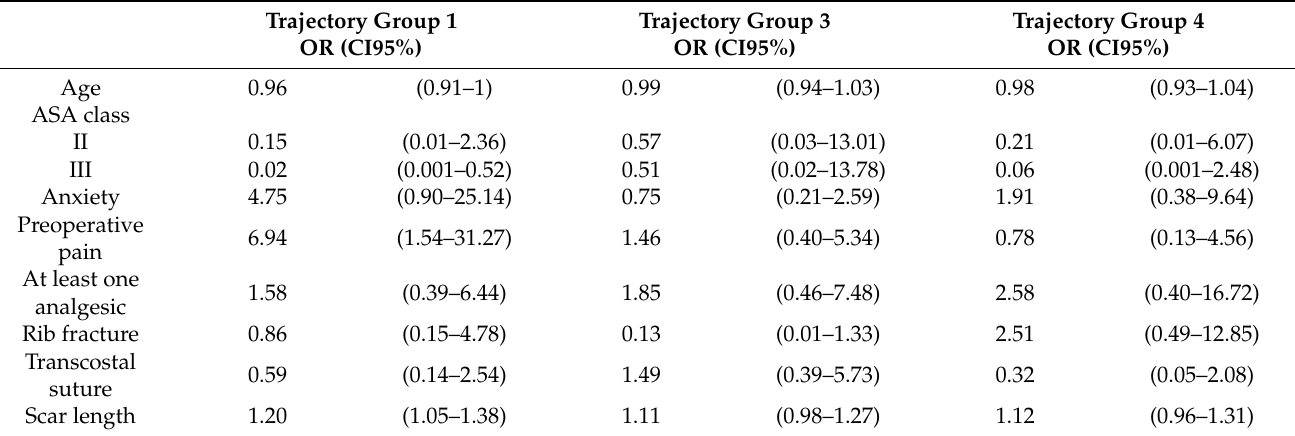
Table 7. Multivariable analysis of factors linked to pain trajectories (trajectory group 2 as